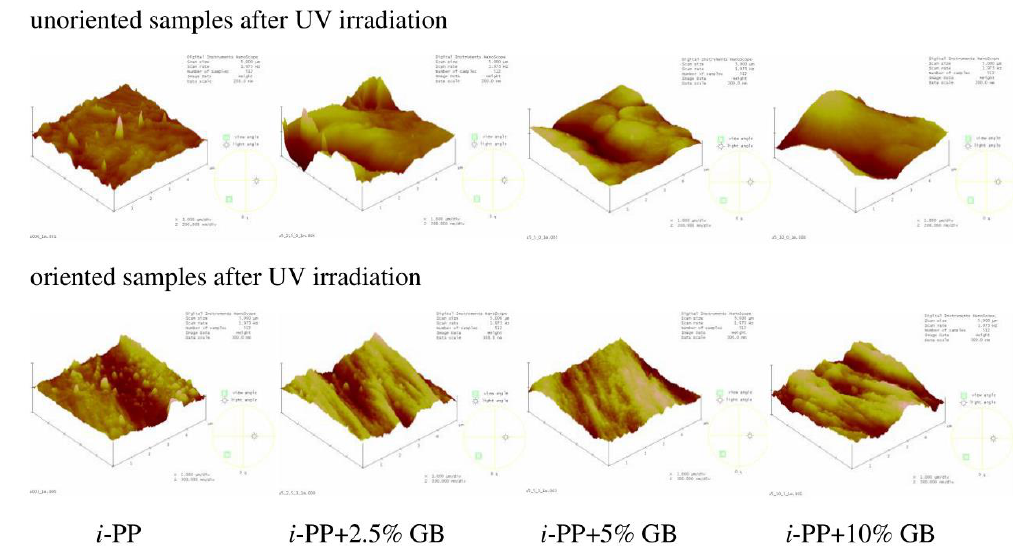
Figure 8. AFM images of UV irradiated unoriented ( top ) and oriented ( bottom ) neat i -PP film and i -PP films with different content of glass beads (GB). Scan area: 5 μm × 5 μm, z-scale for the unoriented films: 200 nm, for the oriented films: 300 nm.